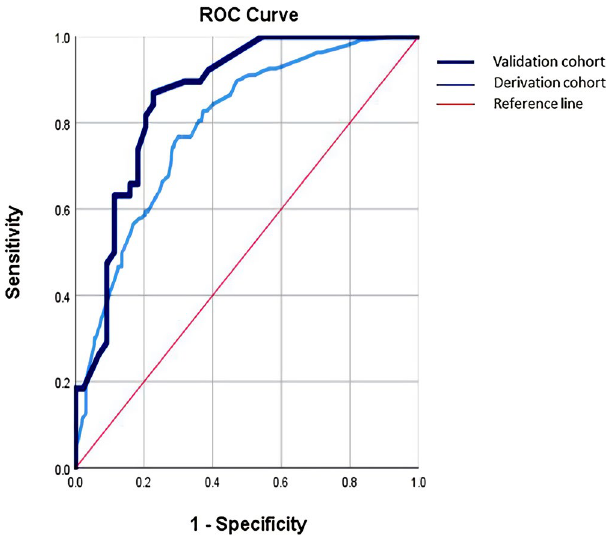
Figure 1. ROC curves for the scoring system in validation cohort .AUC = 0.790 (0.744–0.836), sensitivity = 0.767, specificity = 0.699. p < 0.001. Hosmer Lemeshow Test p = 0.964. ROC curves for the scoring system validation cohort. AUC = 0.860 (0.780–0.941), sensitivity = 0.868, specificity = 0.773, p < 0.001. Hosmer Lemeshow Test p = 0.244. ROC receiver operating characteristic, AUC area under the curve.